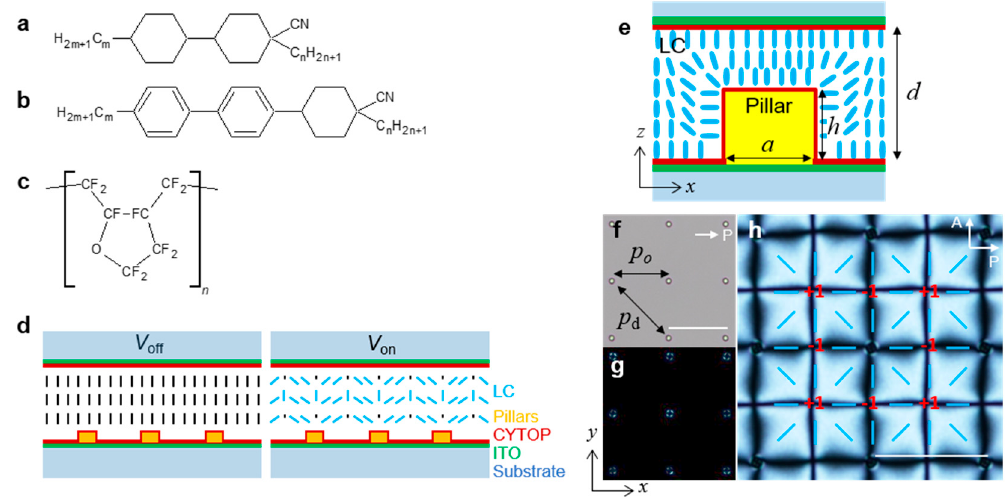
Figure 1. Molecular structures of materials and schematics of the LC/Pillar system: ( a ) CCN-mn; ( b ) NCB-mn; and ( c ) CYTOP. ( d ) Schematic of the LC director field at voltage off/on. ( e ) Schematic of LC director field and substrate structure. ( f ) Square array of cylindrical pillars. ( g ) Homeotropic LC configuration: slightly distorted LCs around pillars (brightness and contrast are adjusted for visibility). ( h ) LC configuration with +1 and -1 umbilical defects. P, polarizer; A, analyzer. Scale bars are 40 μ m.